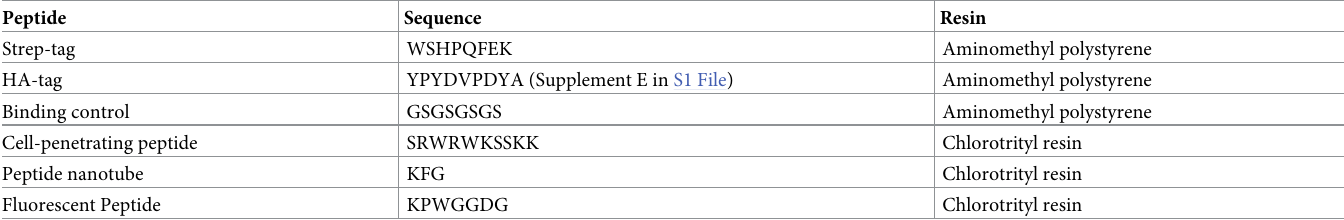
Table 1. Sequences of peptides synthesized with frugal